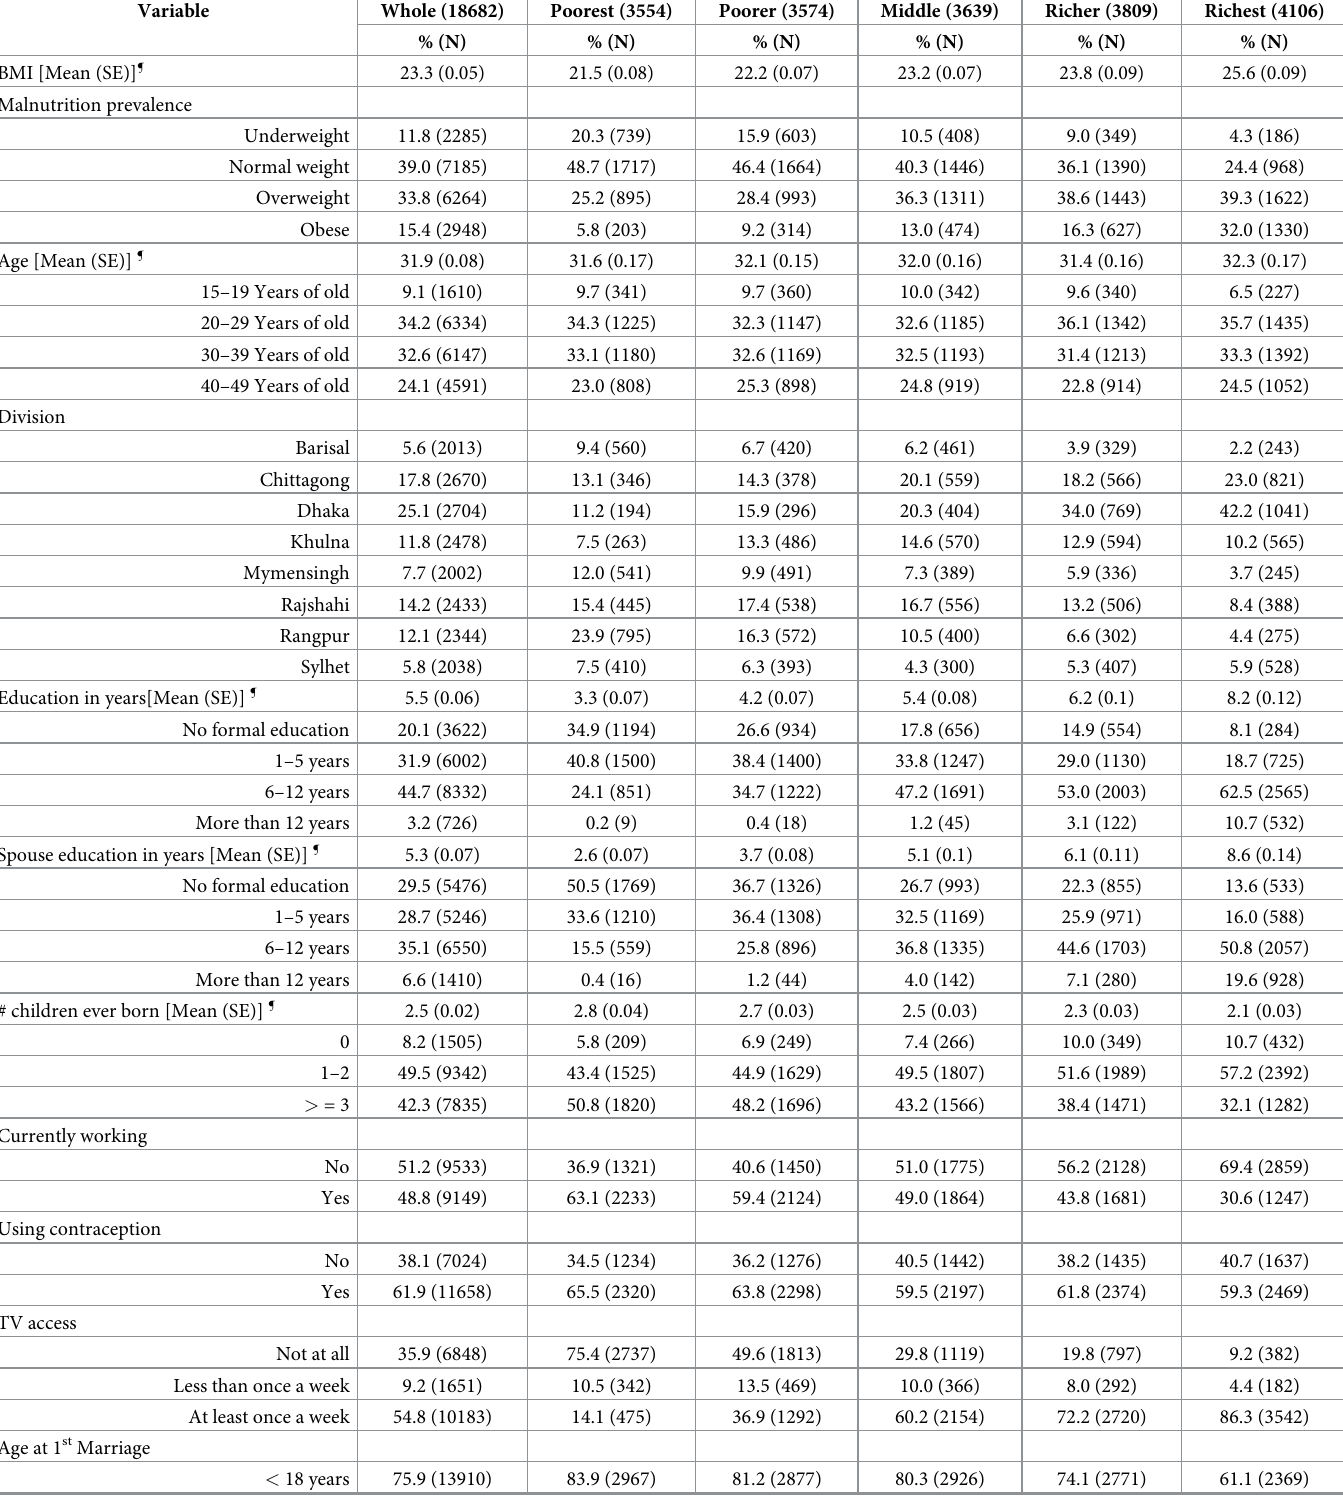
Table 1. Descriptive information of BMI and background characteristics by total sample and by individual quintile of the wealth index, BDHS 2017–18.